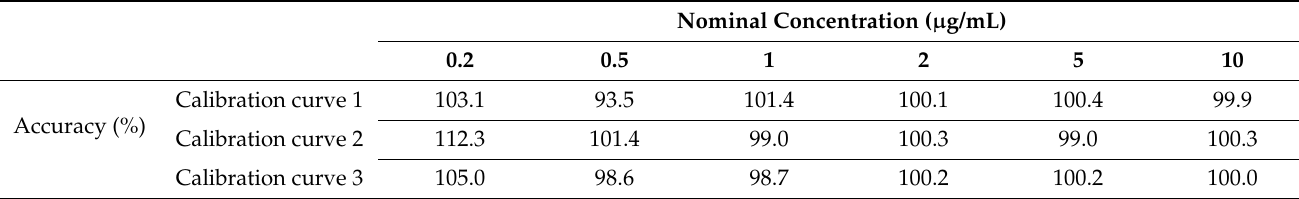
Table 3. Back-calculated values of SPAR in calibration samples.